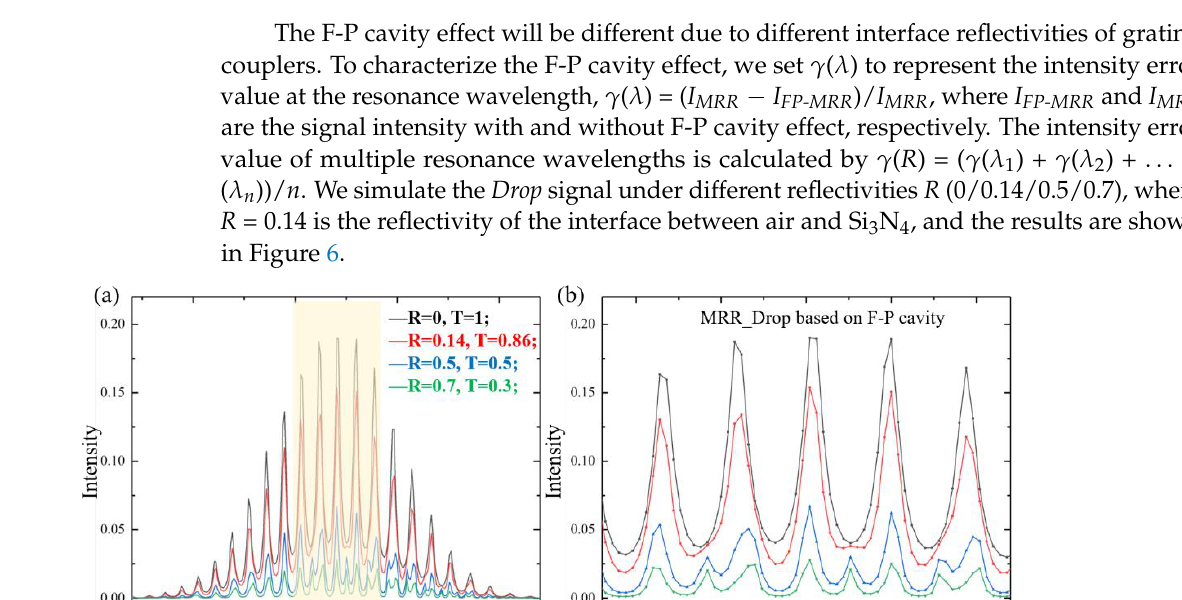
Figure 5 . ( a ) The equivalent incident light I total of F-P cavity effect (wavelength resolution Δλ = 0.01 nm). ( b ) Detailed information about the wavelength range of 782.5 nm – 787.5 nm with a wave- length resolution of 0.01 nm.